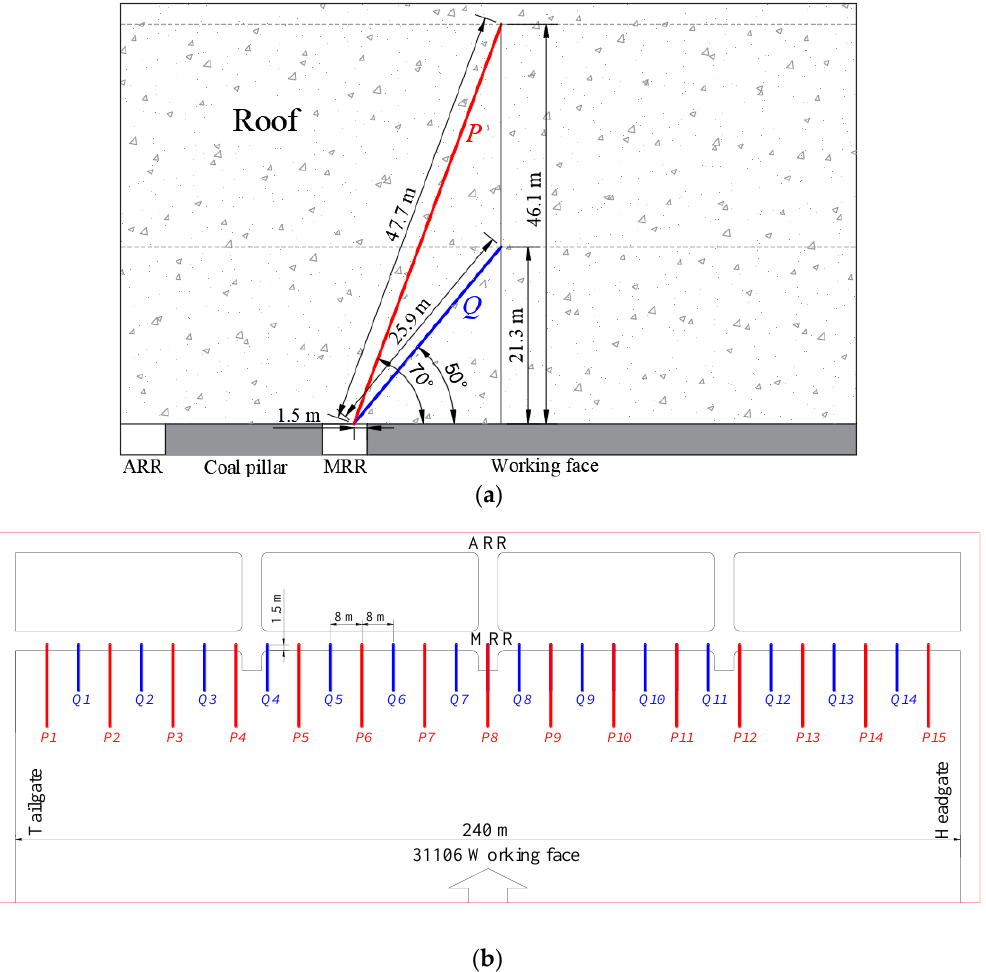
Figure 16. Roof fracturing scheme of retracement roadway: ( a ) fracturing borehole profile inside the main retracement roadway; ( b ) borehole layout.